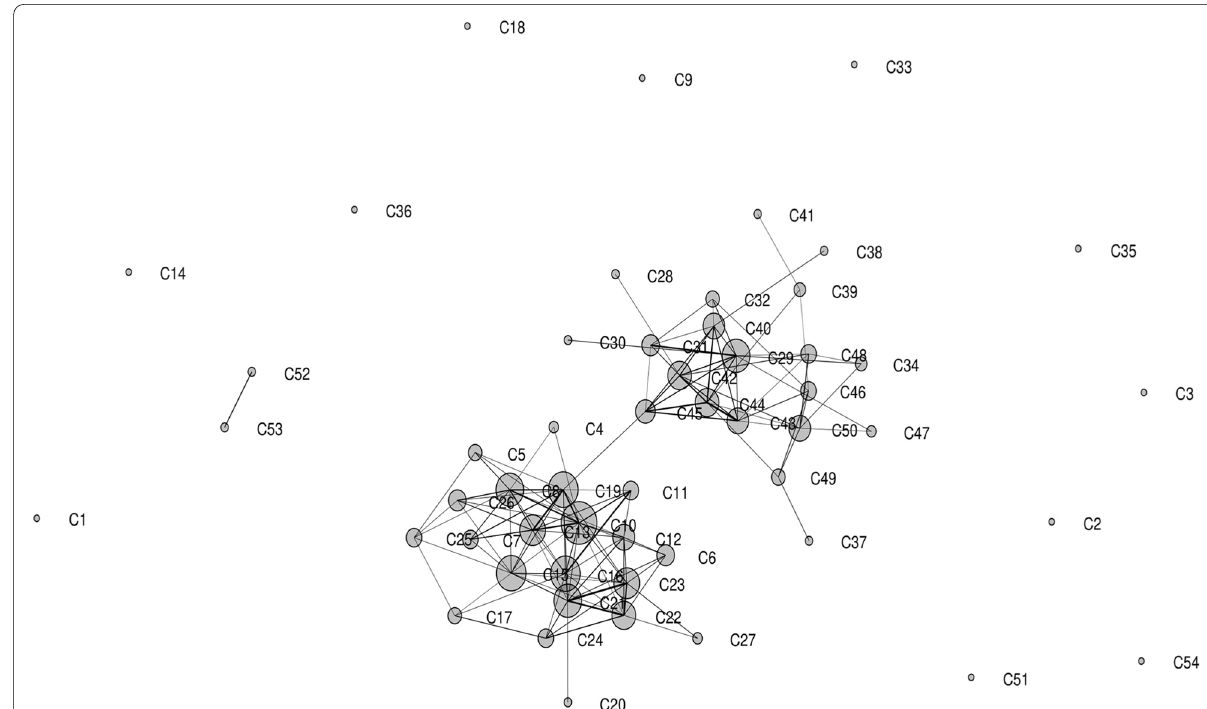
Fig. 6 Euclidean similarity index with Fruchterman-Reingold algorithm data-based population characterization among 54 different Capsicum accessions